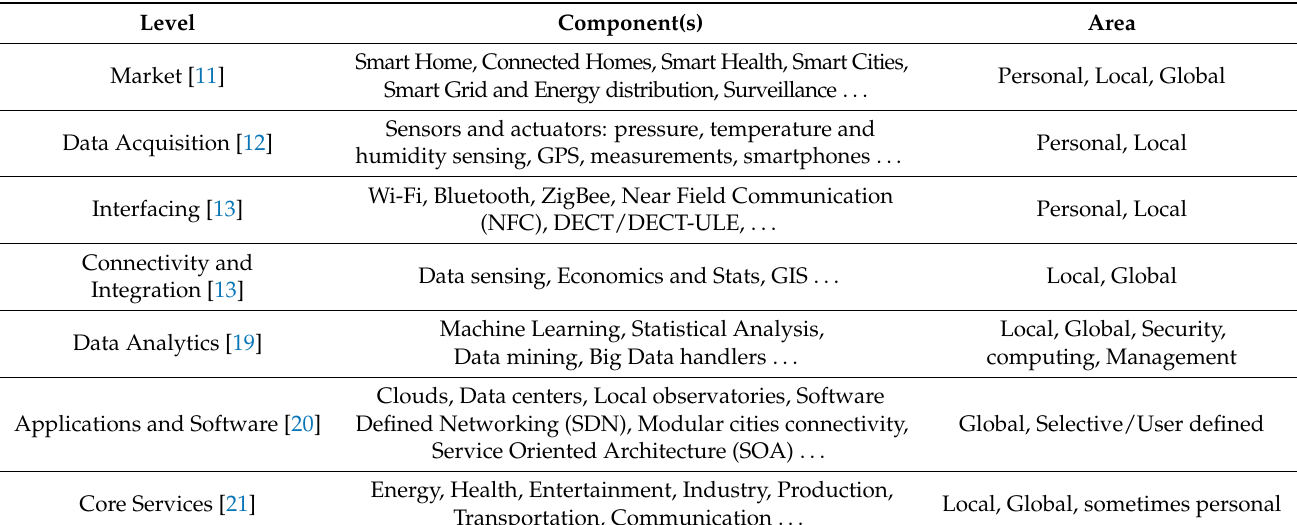
Table 1. Components based on the consumer